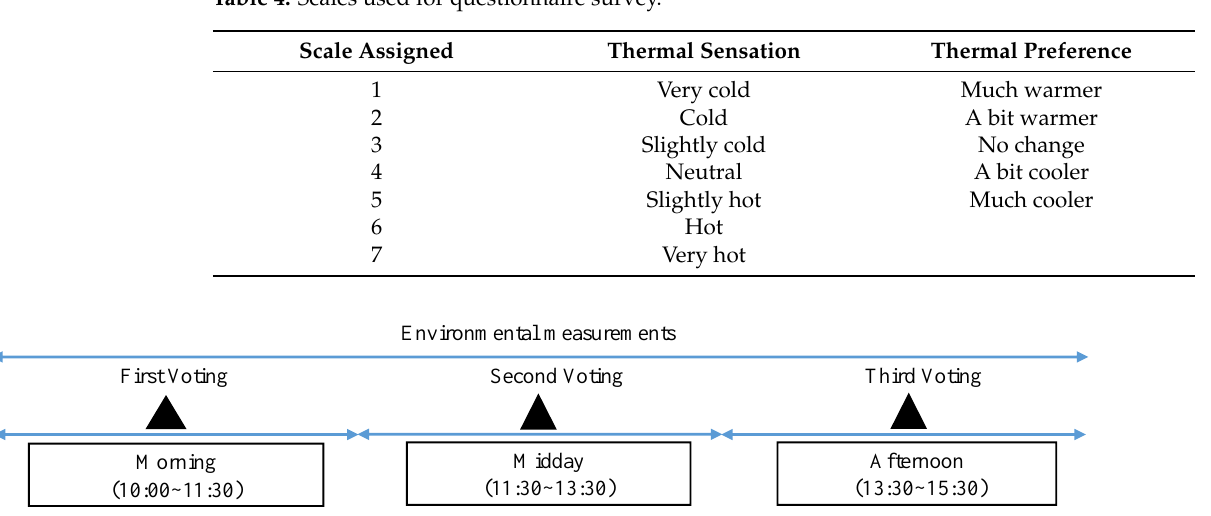
Figure 4. The procedure of thermal comfort survey and environmental measurements. The voting time environmental quantities were also noted from the continuous measurement.